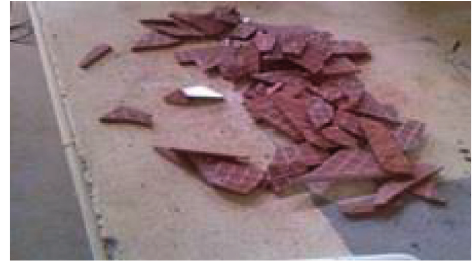
Figure 2: Waste ceramic tiles from construction sites.